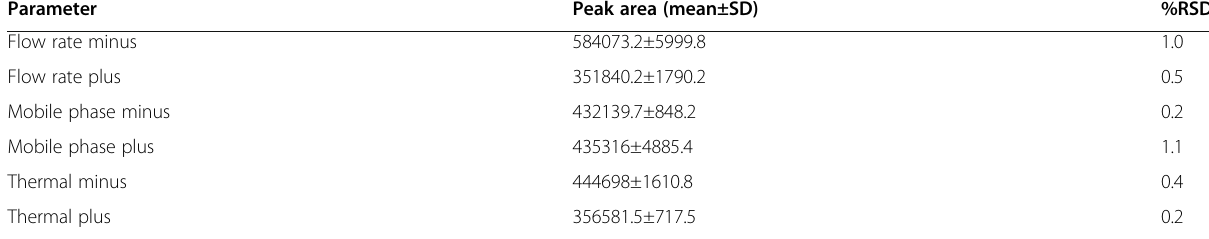
Table 8 Robustness of ertugliflozin ( n =6)